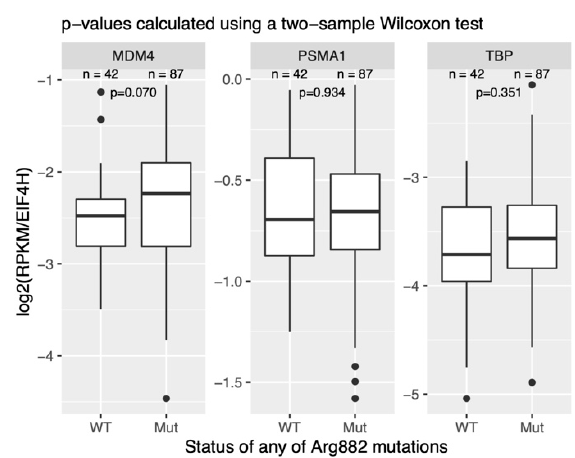
Figure 4. Comparison of MDM4 transcript expression in NK-AML samples with and without the DNMT3A R882H mutation. The expression values across samples are normalized to the housekeeping gene EIF4H. PSMA1 and PSMD6 are housekeeping controls. n is the number of samples in each group. The data was retrieved from the publicly available dataset GSE67040. RPKM—reads per kilobase of transcript per million of mapped reads.